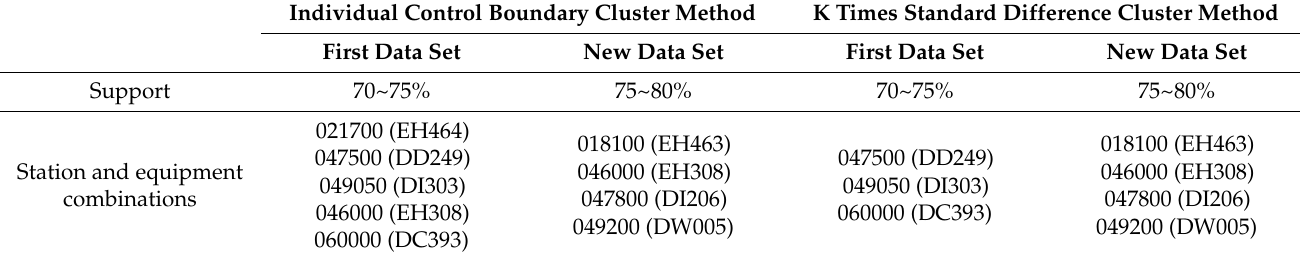
Table 4. Comparison of association rules obtained using new data with those obtained previously. Individual Control Boundary Cluster Method First Data